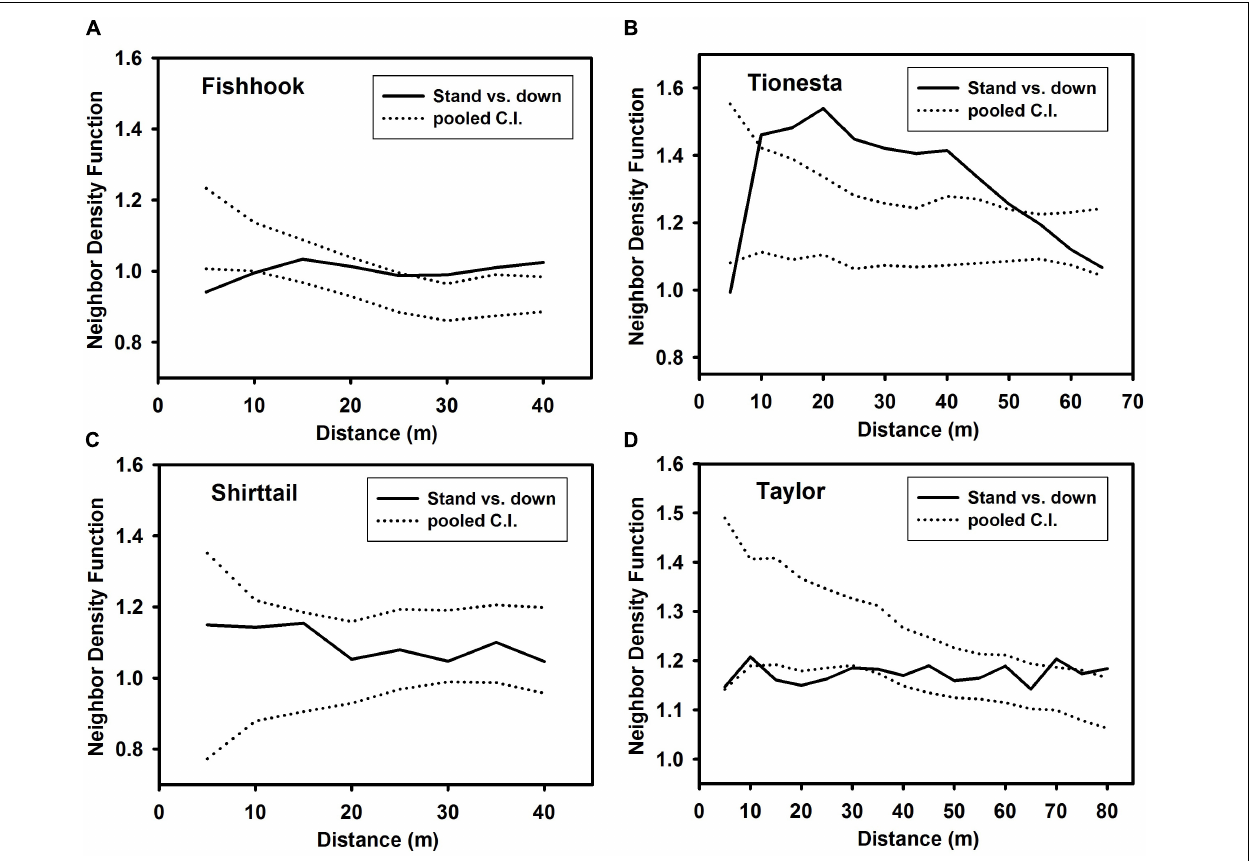
FIGURE 5 | Bivariate Neighbor density function representing spatial relationship between standing survivors (‘standing’) and fallen trees (‘down’) at the four sites. (A) Fishhook; (B) Tionesta; (C) Shirttail; and (D) Taylor. Note that x and y axes differ among the panels in this figure. Dotted lines represent 99% confidence intervals; a value of unity on the y axis corresponds to complete spatial randomness. Values greater than the upper confidence interval indicate significant spatial attraction between standing and fallen trees at that distance; values less than the lower confidence interval indicate significant spatial segregation between standing and fallen trees at that